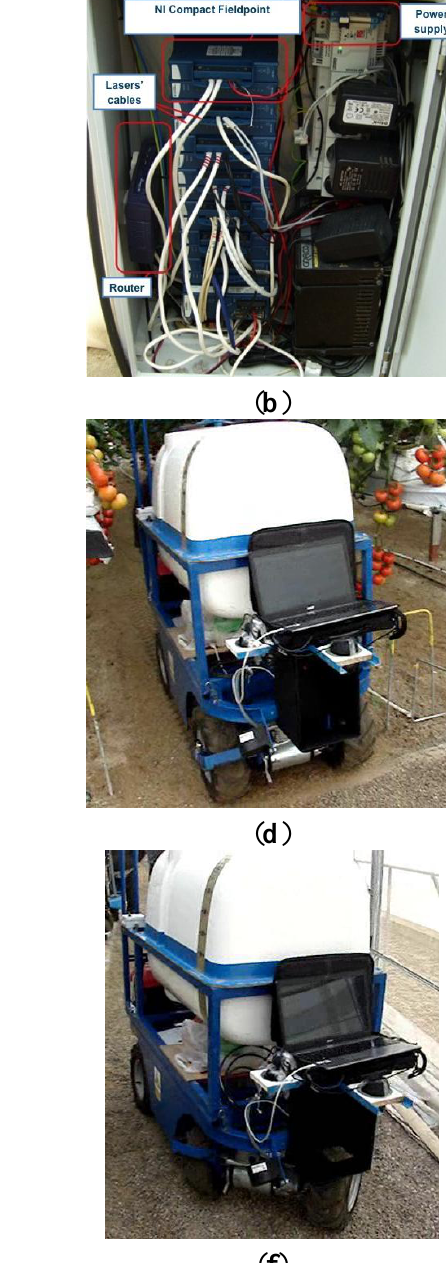
Figure 9. Results of some physical experiments testing the performance of the template- matching approach. ( a ) Laser emitters. ( b ) NI Compact Field Point. ( c ) Vehicle in the greenhouse corridor. ( d ) Leaving the corridor. ( e ) Turning to the right side. ( f ) Forward motion in the new